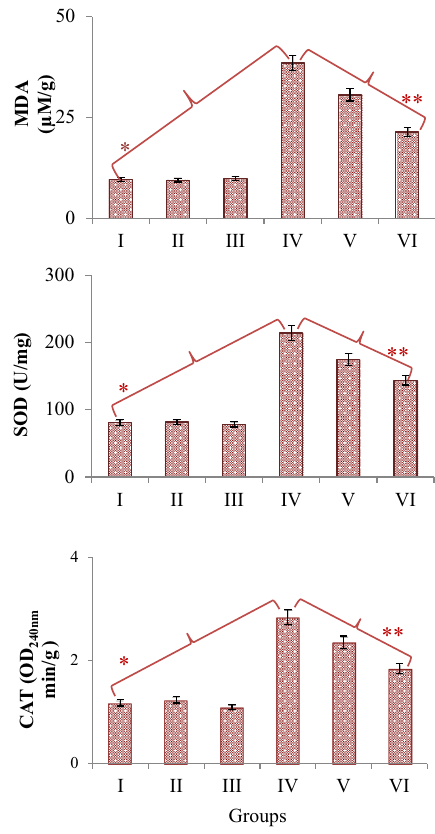
Figure 5. Protective role of Bmex against the biochemical changes induced by glyphosate. Group I: Control, Group II: 350 mg/L Bmex, Group III: 700 mg/L Bmex, Group IV: 500 mg/L glyphosate, Group V: 500 mg/L glyphosate + 350 mg/L Bmex, Group VI: 500 mg/L glyphosate + 700 mg/L Bmex. Values are shown as mean ± SD ( n = 10). *indicates the statistical difference between Groups I and IV, **indicates a statistical difference between Groups IV and VI ( p <